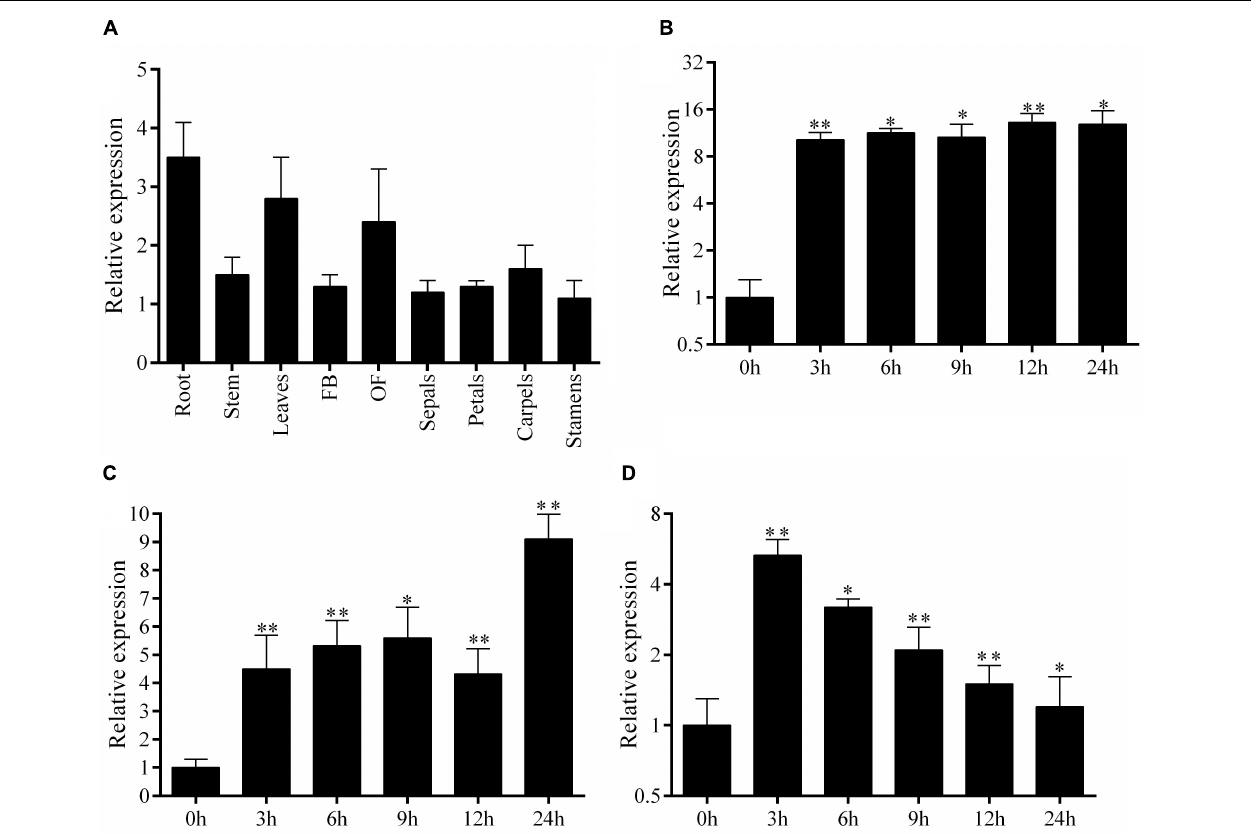
FIGURE 1 | Endogenous expression profile of SlbHLH22 and expression levels under abiotic stress. (A) Expression profile of SlbHLH22 in different parts of WT plants, including root; stem; leaves; FB, flower bud; OF, opened flower; petals; sepals; stamens; and carpels. Expression analysis of SlbHLH22 from leaves of WT spray with (B) 200 mM NaCl, (C) 100 mM D -mannitol, (D) 100 mM H 2 O 2 over 0 to 24 h time intervals. Student’s t -tests were used in comparison. Data represent mean of ± SE for three independent biological replicates ( n = 3). ∗ and ∗∗ represent the significant difference at P -value ≤ 0.01 ∗∗ /0.05 ∗